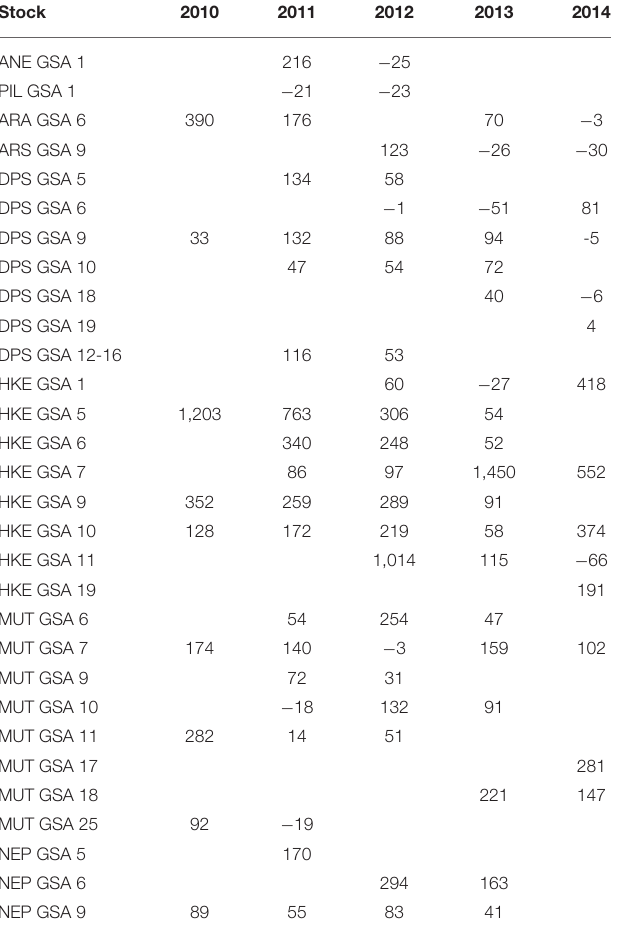
TABLE 5 | Difference (in %) between the scientific catch advice and the realized catches for each year and stock for which a short term forecast was carried